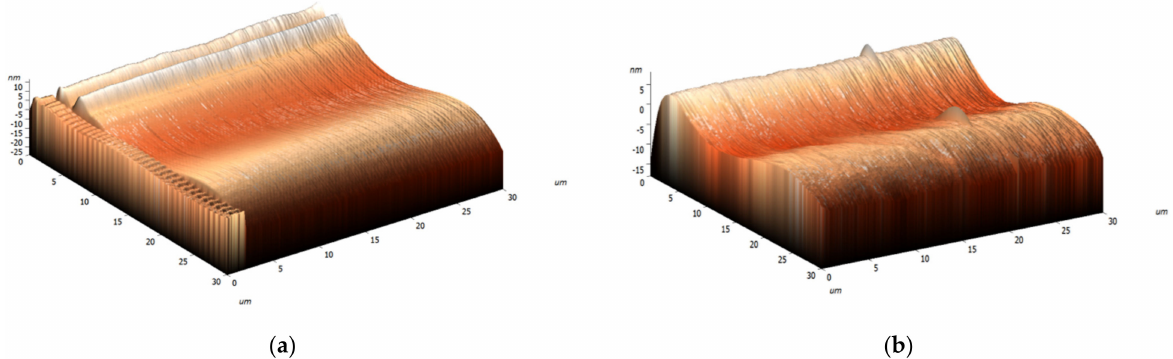
Figure 4. Change in the roughness for the pure MgF 2 ( a ) and for the MgF 2 + CNTs ( b ).